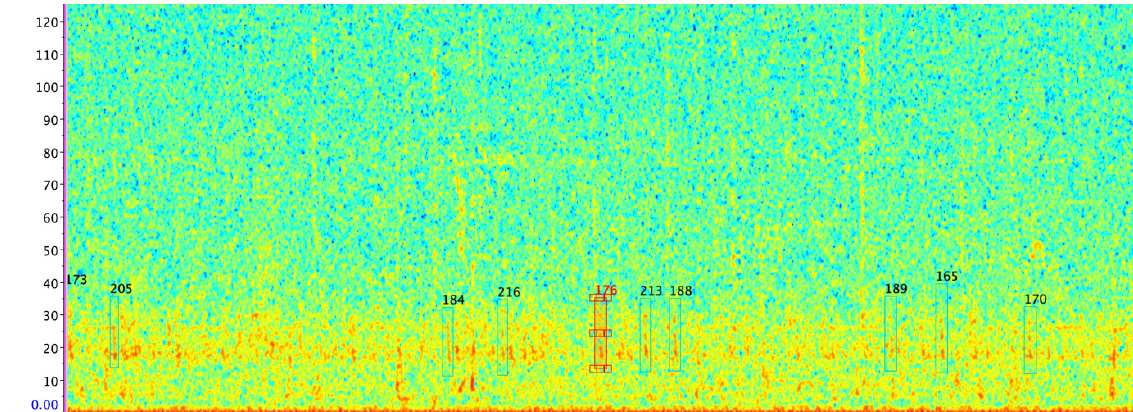
Figure A3. F20P log examples from file Balleny20150325_130000 for the location Balleny Island.